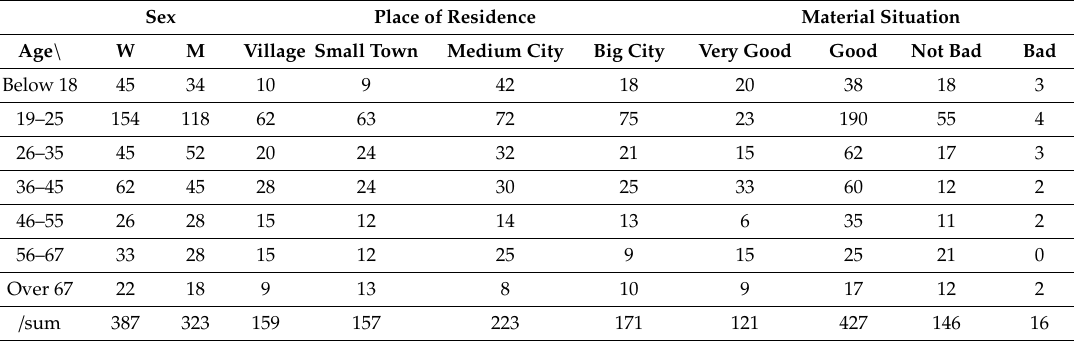
Table 1. Information on respondents participating in the CAWI